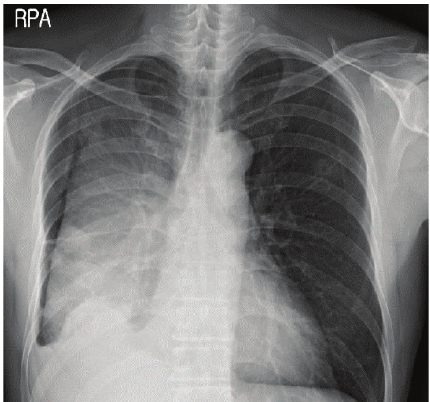
Figure 1: Large fissural loculated effusion in the right hemithorax.